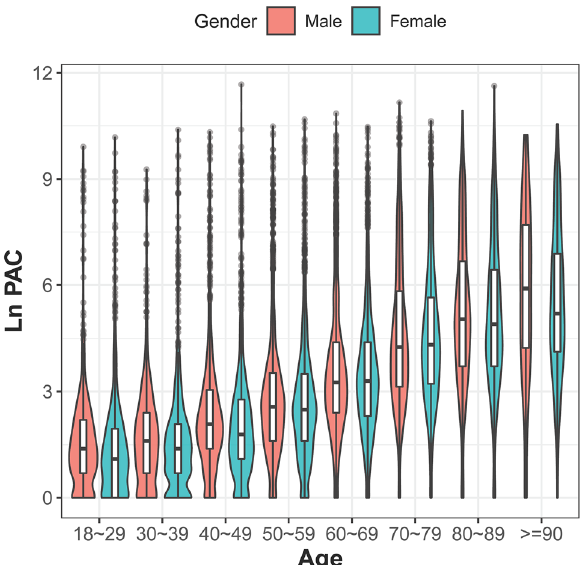
Figure 1. Violin plot. The PAC distribution is presented by age and gender. The PAC burden increased with age ( p for trend < 0.05), and similar distribution across all age bracket was found in both gender. The white bar in each violin plot presents interquartile range, and the central black horizontal line is median. The black lines stretched from the bar are the lower and upper adjacent values defined as first quartile − 1.5 IQR and third quartile + 1.5 interquartile range respectively. The colored area is the density plot, and the width suggests the